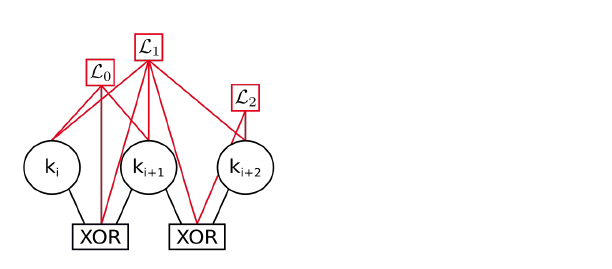
Figure 4: Leakage model with distance and value